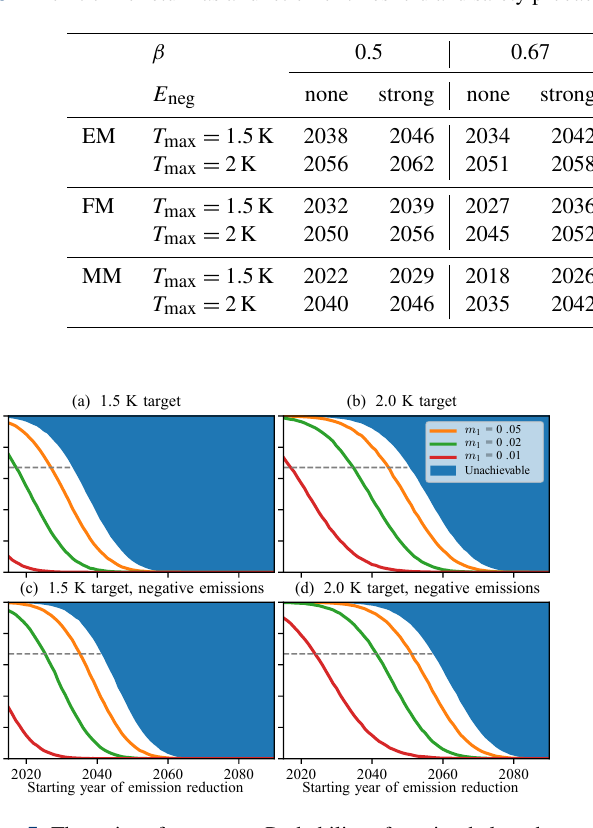
Figure 5. The point of no return. Probability of staying below the 1.5K (a, c) or 2.0K (b, d) threshold when starting emission reduc- tions in a given year, for different policies as described by Eq. (14) with different choices for m 1 , the rate of mitigation increase per year. Top and bottom panels show the cases without and with strong negative emissions, respectively. The point of no return for a given policy is given by the point in time where the probability drops below a chosen threshold. The default threshold of two-thirds is dashed. The unachievable region is bounded by the extreme miti- gation scenario.